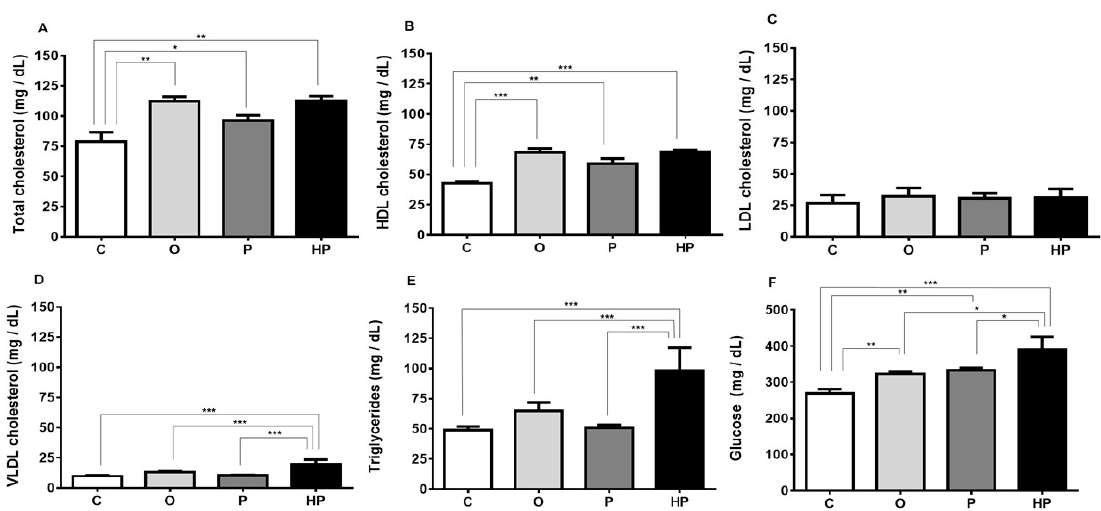
Figure 3. Changes in serum parameters according to each diet. Total cholesterol ( A ); high-density lipoprotein (HDL) cholesterol ( B ); low-density lipoprotein (LDL) cholesterol ( C ); very low-density lipoprotein (VLDL) cholesterol ( D ); triglycerides ( E ); glucose ( F ). Data expressed as mean ± standard error of the mean ( n = 6). * p ≤ 0.05; ** p ≤ 0.01; *** p ≤ 0.001. C = control group; O = olive oil group; P = palm oil group; HP = hybrid palm oil group.